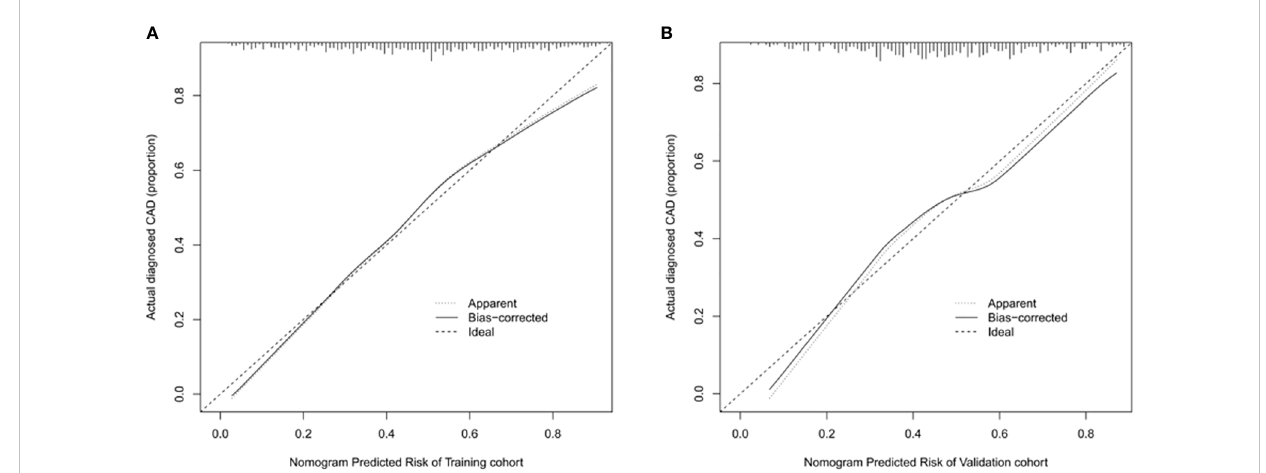
FIGURE 5 Calibration curve of nomogram model for predicting carotid atherosclerosis in patients with T2DM. (A) In the training cohort, B=1000 repetitions, boot mean absolute error=0.021, n=733. (B) In the validation cohort, B=1000 repetitions, boot mean absolute error=0.032, n=316. The X-axis represents the predicted risk of carotid atherosclerosis; Y-axis represents the actual diagnosed carotid atherosclerosis. Y-axis represents actually diagnosed carotid atherosclerosis. The diagonal dotted line represents the perfect prediction by the ideal model. The solid line represents the performance of the nomogram; the closer to the diagonal dotted line, the better the